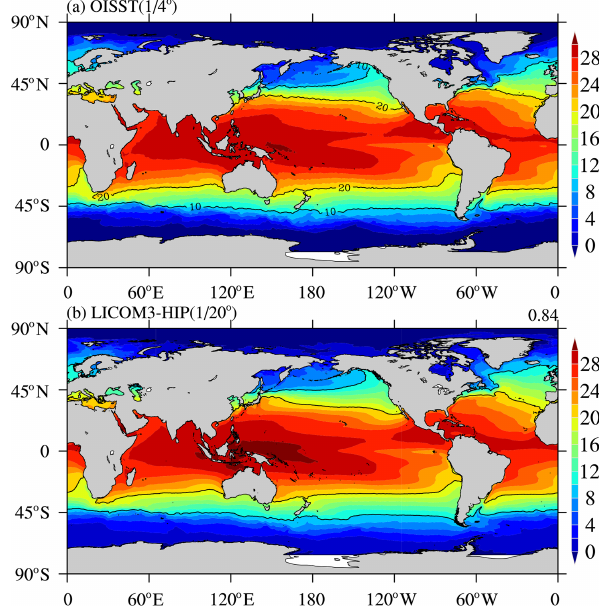
Figure 14. (a) Observed annual mean sea surface temperature in 2016 from the Optimum Interpolation Sea Surface Temperature (OISST); (b) simulated annual mean SST for LICOM3-HIP at 1 / 20 ◦ during model years 0005–0014. Units: ◦